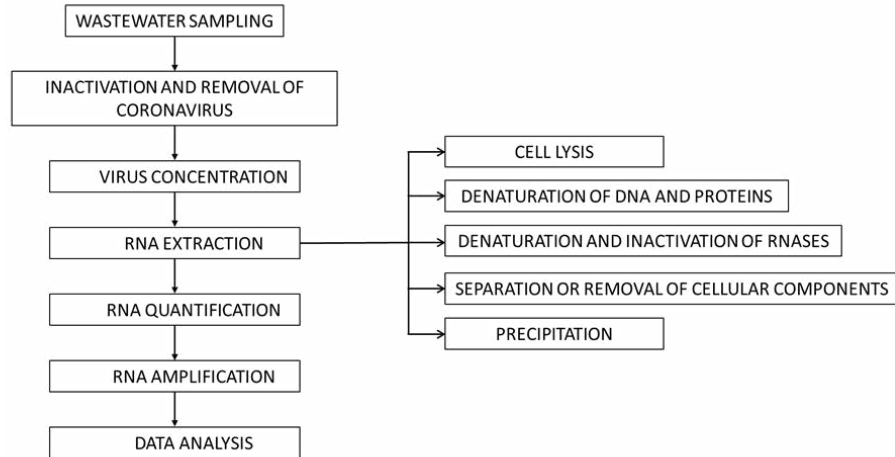
Fig. 1: Process of testing COVID-19 in wastewater